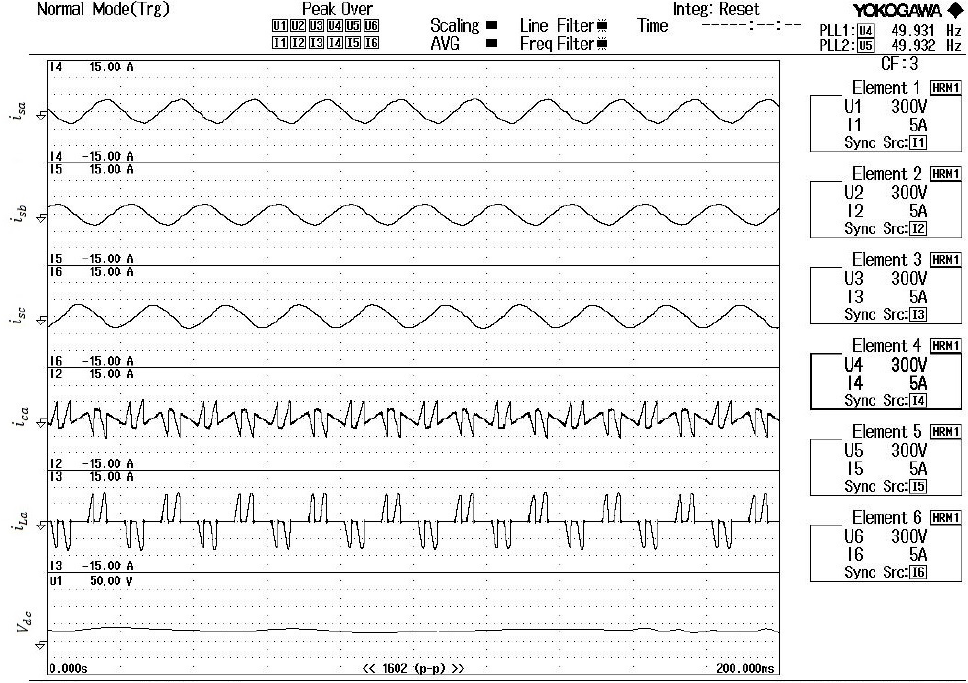
Figure 15. Performance of the compensator for voltage source type nonlinear load.